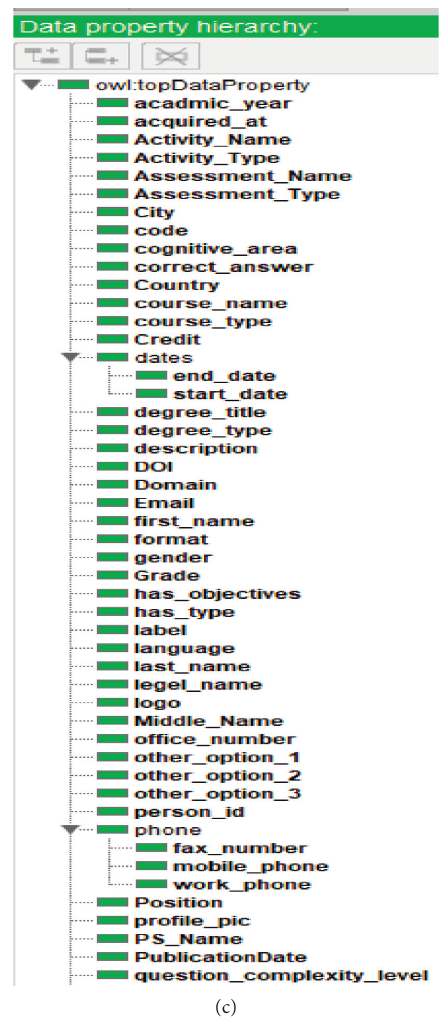
Figure 3: The HEO classes, object, and data type properties